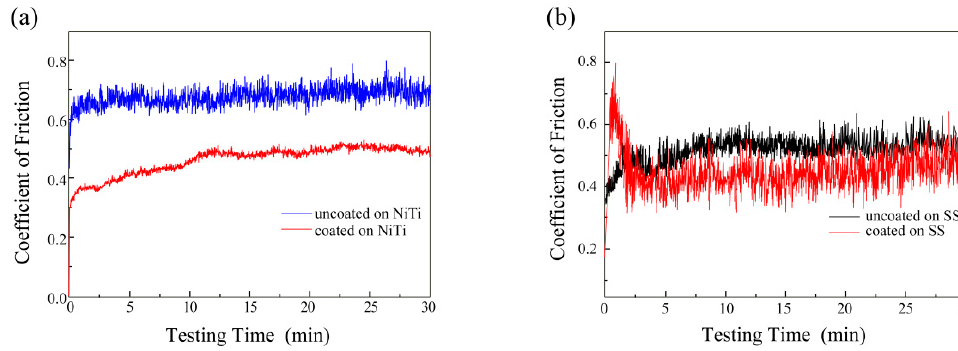
Figure 6. Friction coefficient curve of the coated layers. NiTi group ( a ); SS group ( b